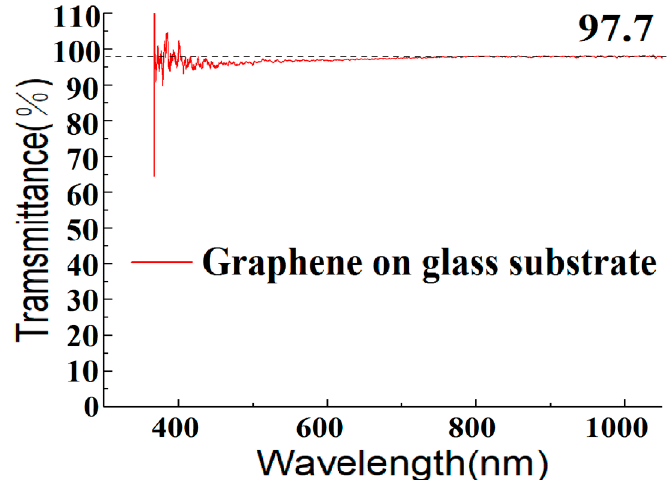
Figure 8. Optical transmittance of the as-grown graphene grown at 900 °C on Cu foil and transferred onto a glass substrate.